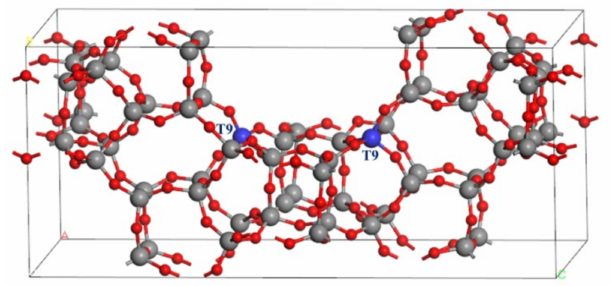
Figure 11. Optimized periodic structure illustrations of BEA zeolite labeled with blue T9